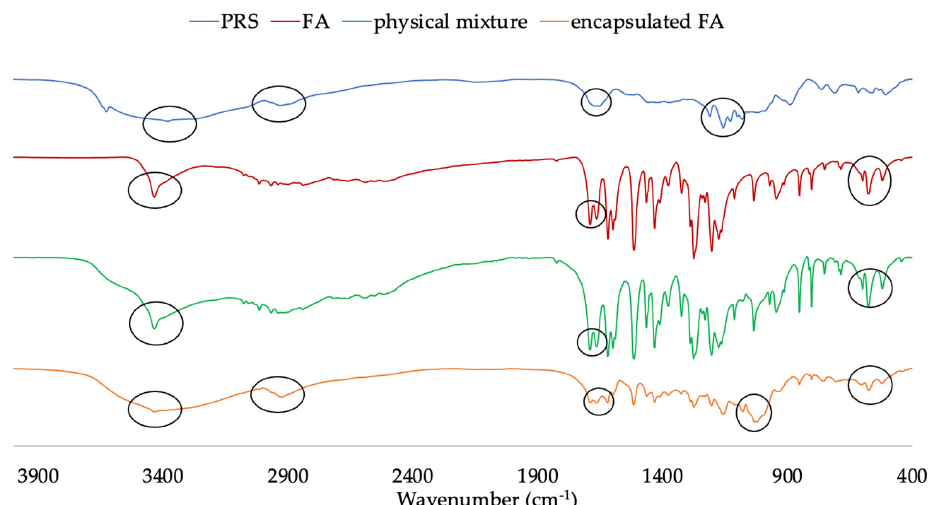
Figure 2. FT-IR spectra of PRS, FA, physical mixture, and encapsulated FA.